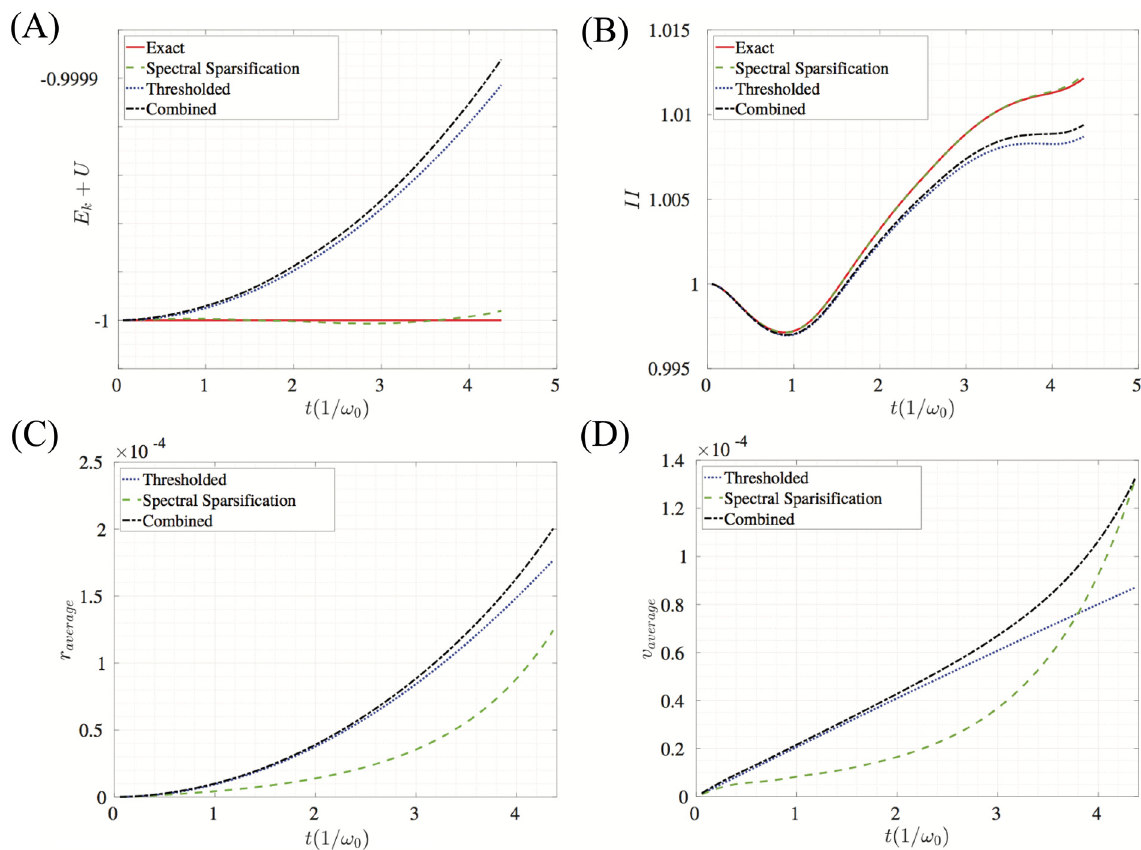
Fig 4. Measures of error and global properties for the sparsified, thresholded, and combined approximations for the surface relaxation problem. Comparisons are made to a system with all non-zero edges included which has been labeled the exact system. (A) Average difference in position between the exact solution and the approximation methods. (B) Average difference in velocity between the exact solution and the approximation solutions. (C) Potential energy, kinetic energy, and total energy of the system for the different methods. Note that there is about a half of unit difference between the thresholded (and combined) total energy and the exact (and sparsified) total energy. (D) Normalized second invariant of the stress